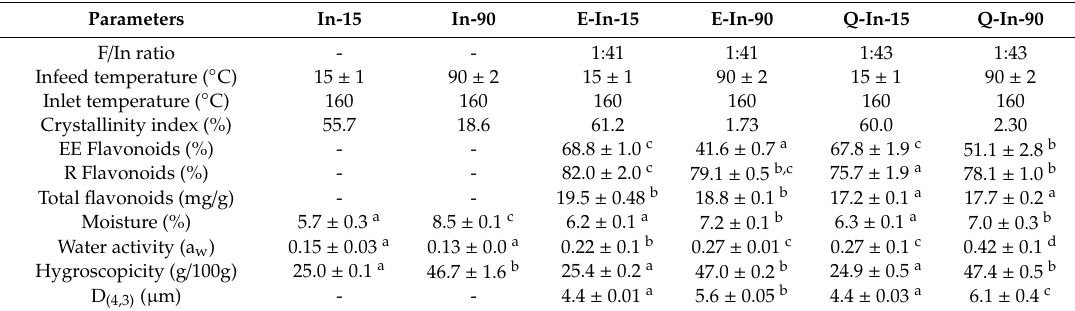
Table 1. Characterization of empty microparticles and flavonoid microparticles at two infeed temperatures (15 ◦ C and 90 ◦ C).